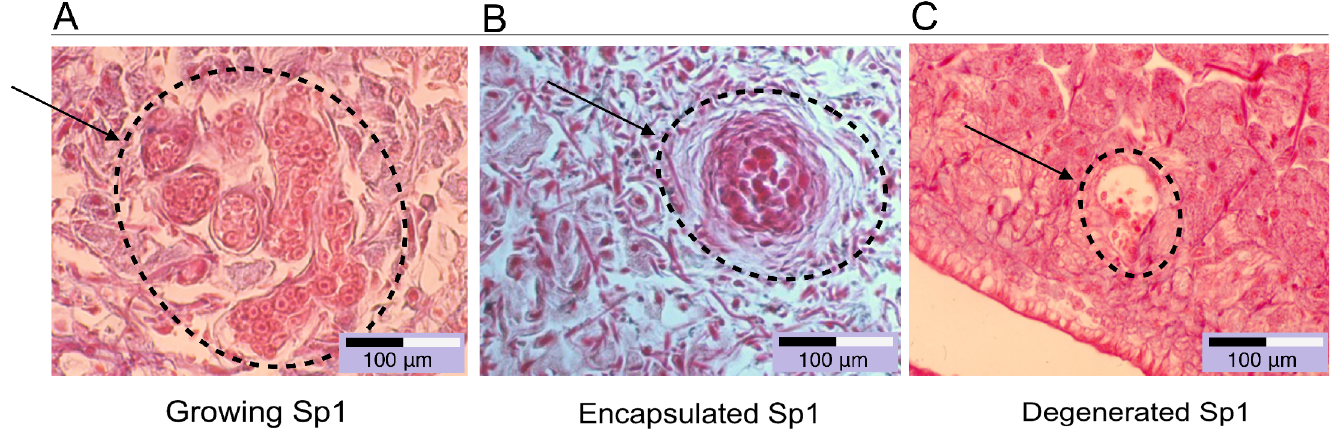
Fig 2. The immune response of B . glabrata to S . mansoni infection. The Brazilian strain of albino B . glabrata (BgBRE) is 100% susceptible (for 10 miracidia and upwards) to its corresponding strain of S . mansoni (SmBRE). When a snail is infected with 10 miracidia of S . mansoni within the same individual compatible and incompatible interactions occur, 3 to 4 miracidia develop normally in the snail ’ s tissues while the others are recognized and encapsulated by the snail ’ s cellular immune response. A. Six-day-old sporocyst in a compatible interaction. B. Encapsulated sporocyst 48 h after primary infection in an incompatible interaction. C. Six-day-old sporocyst in a primed snail. Primed BgBRE are 100% protected against a secondary challenge with SmBRE. Sporocysts from secondary challenge were neutralized by immune humoral factors.